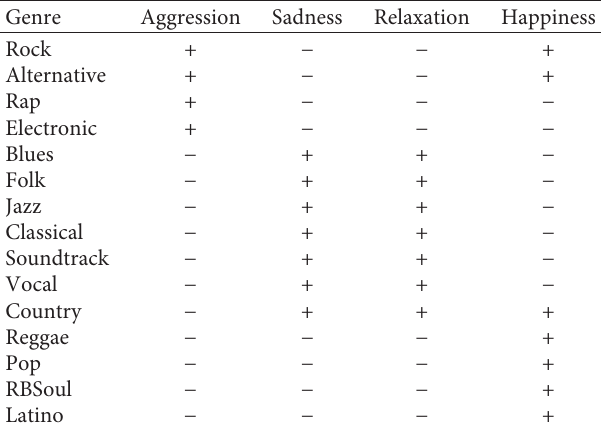
Table 1: Musical genres and moods that